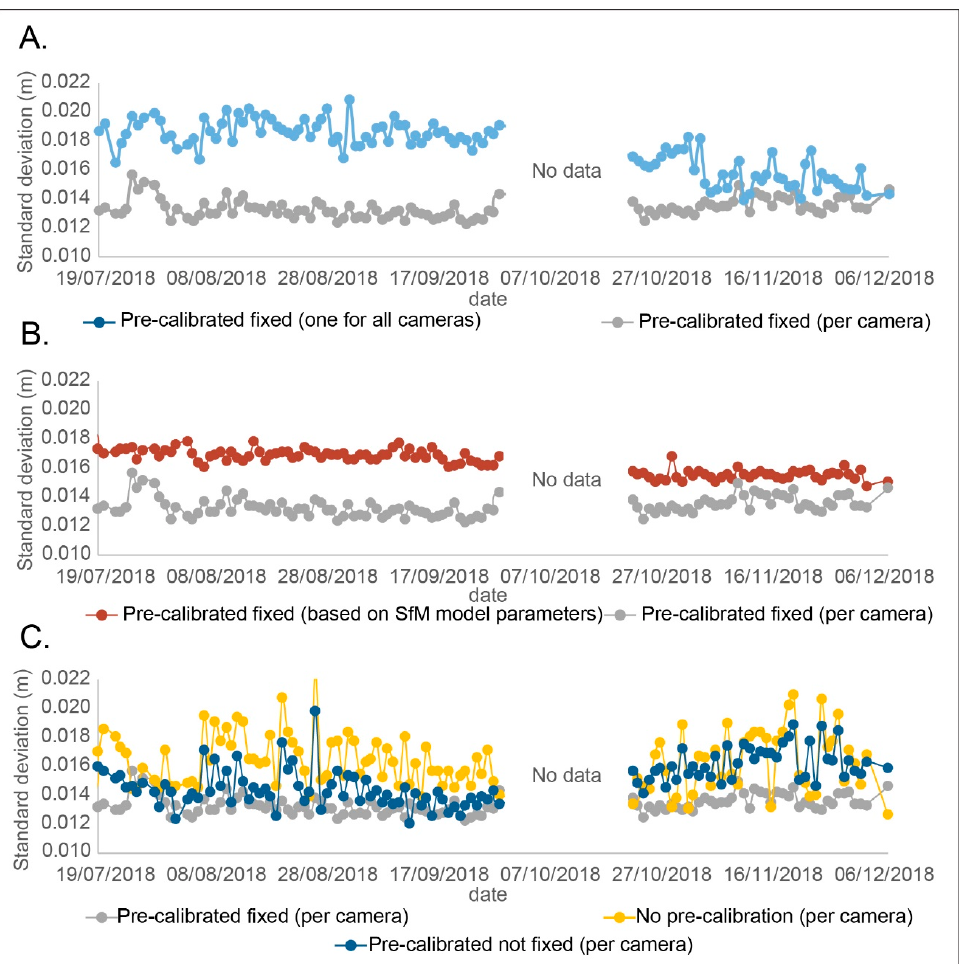
Figure 9. Assessment of accuracy over a selected time frame using TLS data as reference for comparison.